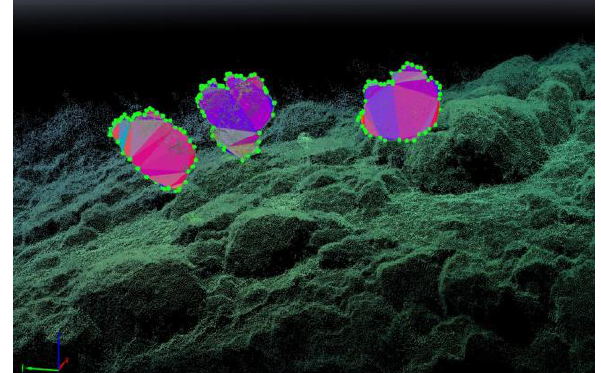
Figure 5. Gorgonian fan surface using Pix4D Mapper Pro software. Manual digitalization process and sum of linked triangles are used to assess the colony fan surface.